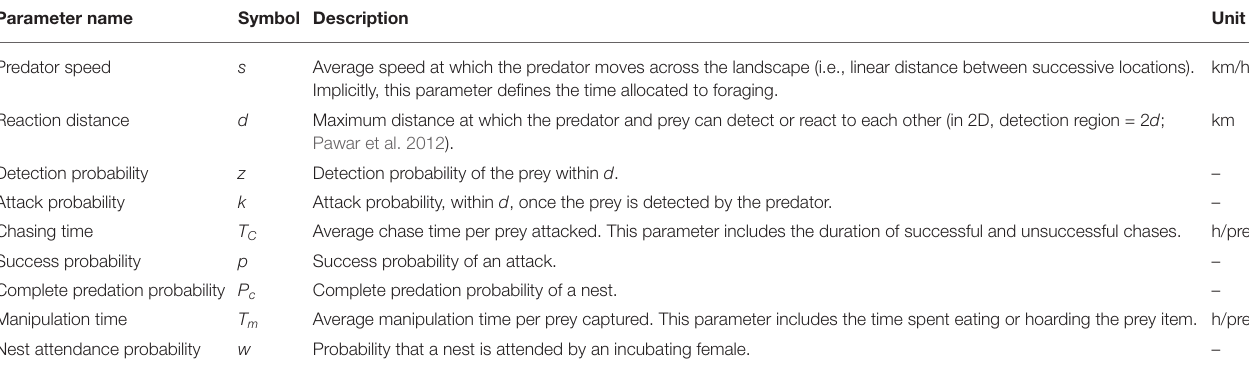
TABLE 1 | Definition of the parameters used in the functional response